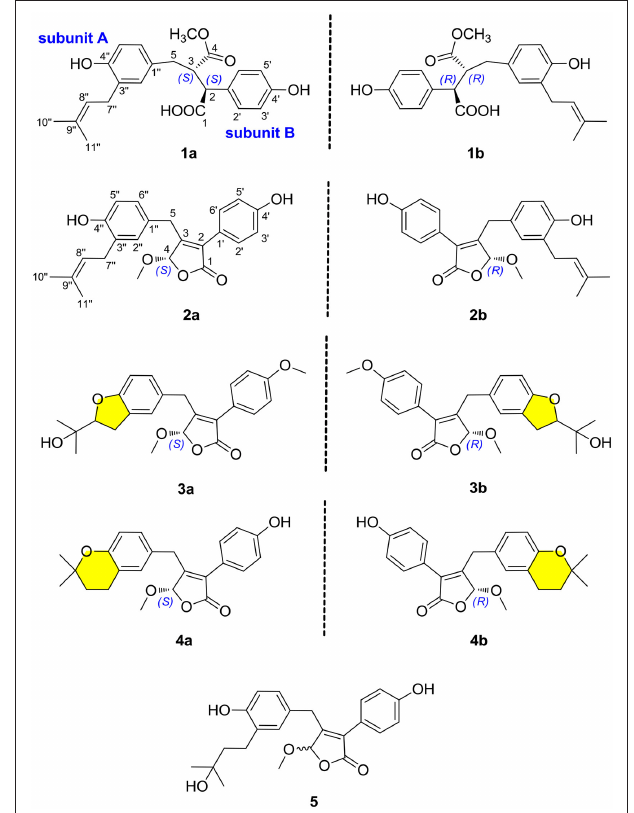
FIGURE 1 | Chemical structures of compounds 1 – 5 .